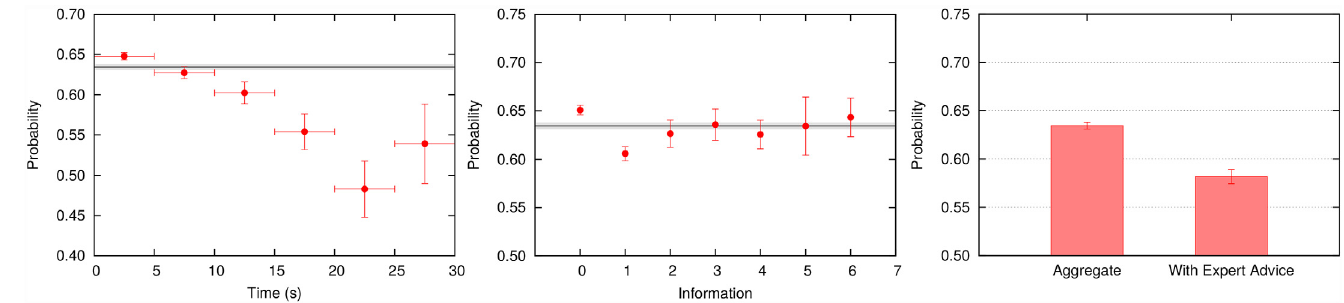
Fig 6. Aggregated strategies: time, information and expert advice dependences. (Left) The probability to follow any of the described strategies depending on the time spent to make the decision. The range between 0 to 30 seconds has been divided in bins of 5 seconds. (Center) The probability to follow any of the described strategies depending on the number of different information panels consulted. (Right) The bar on the left accounts for the probability to follow any of the described strategies, whereas the bar on the right indicates the same, but conditioned to having clicked on the expert ’ s advice panel. Solid black line denotes the total probability while the limit of the shaded area and the error bars denote the Standard Deviation.